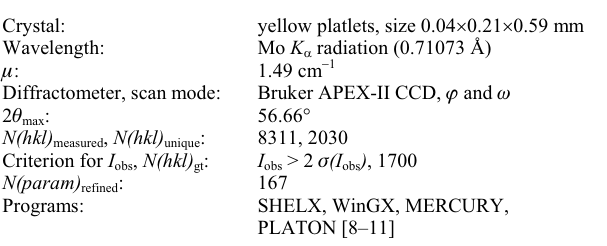
Table 1. Data collection and handling.